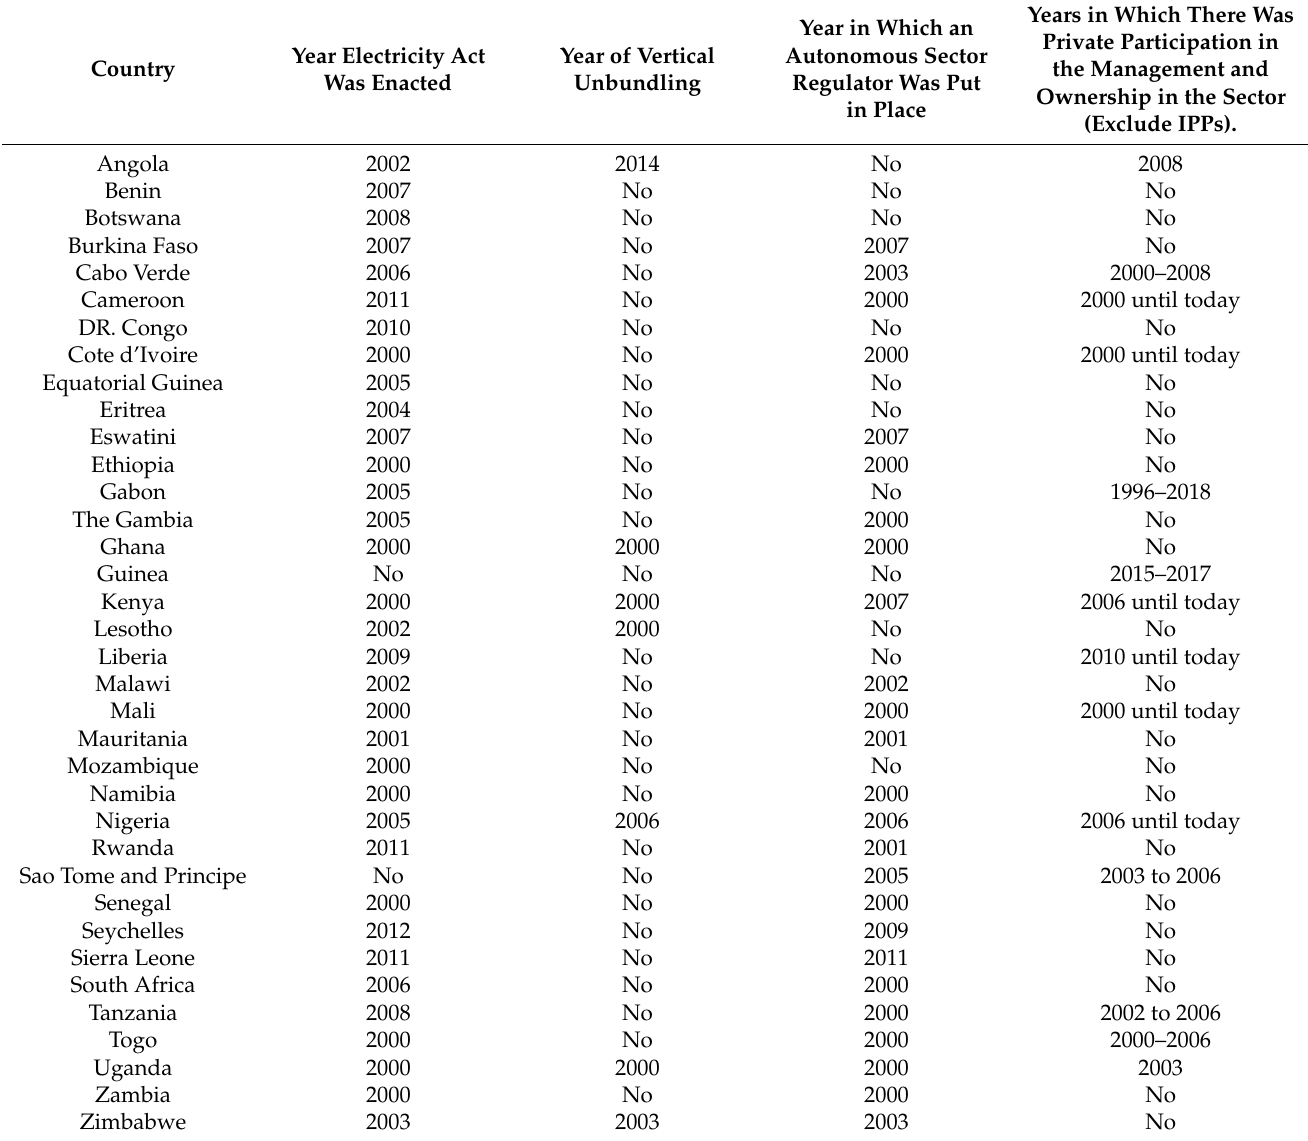
Table A1. Years in which the countries undertook the different reform